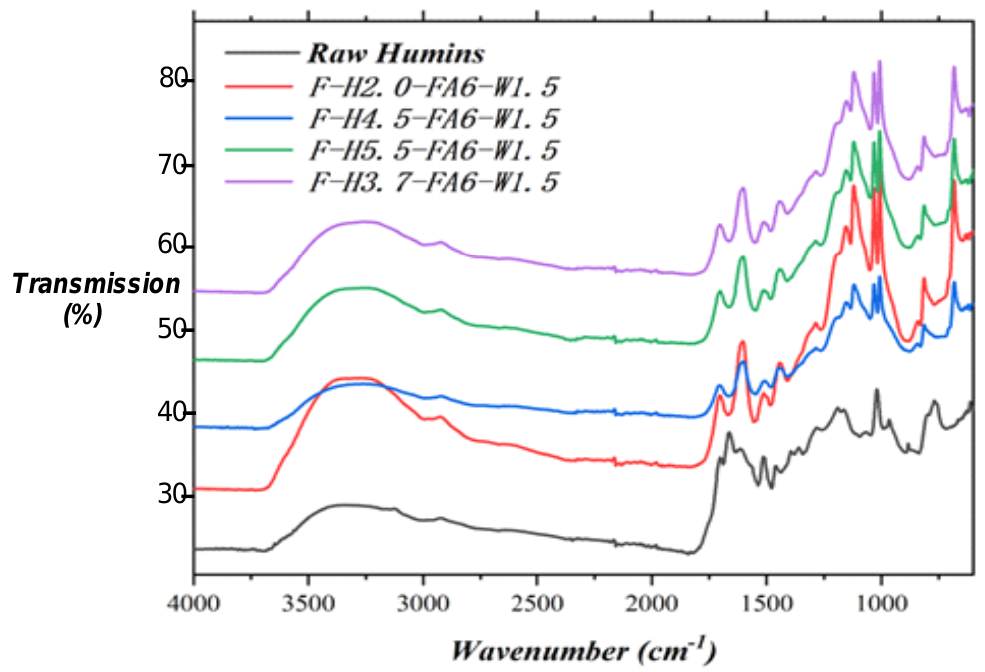
Figure 13. FT-IR of the different mixes of humins (H) and furfuryl alcohol (FA) used for the preparation of the tannin – humins foams.